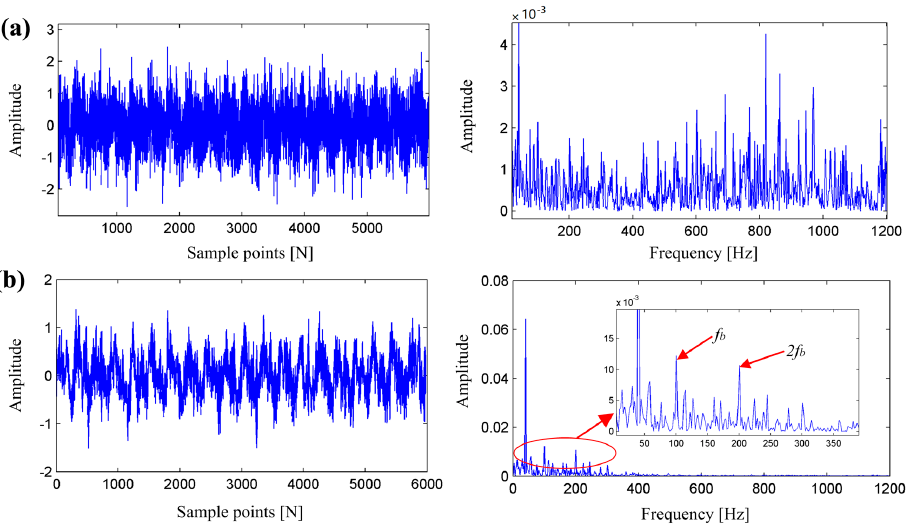
Figure 10. The extracted feature signals and their envelop spectrum. ( a ) The median value of singular values based SVD method; ( b ) The Difference spectrum singular values based SVD method.